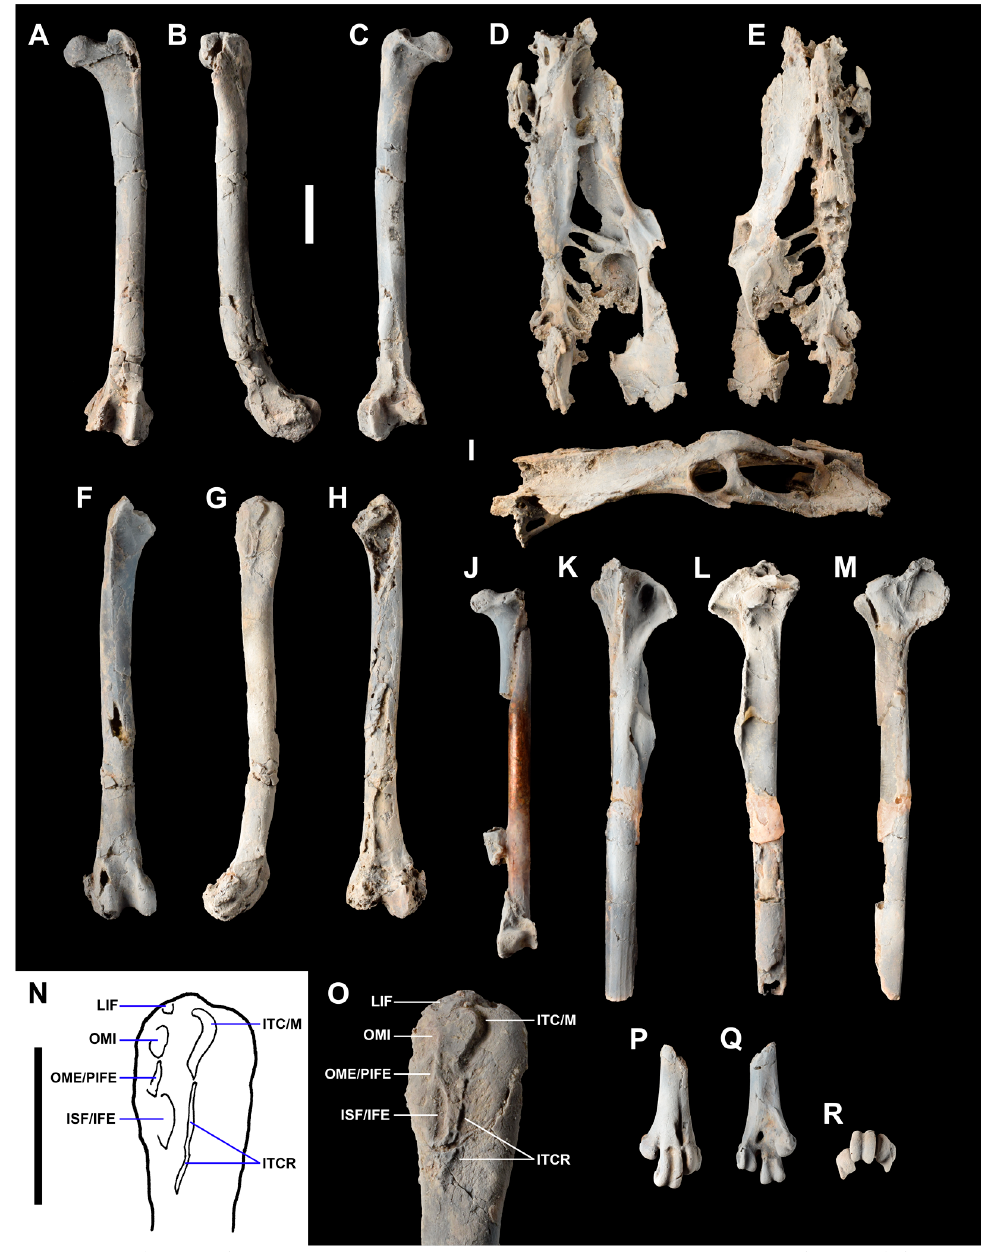
Figure 3. Holotype of Anachronornis anhimops nov. gen. et sp. (USNM 496700): femora, left cranial ( A ), lateral ( B ), caudal ( C ), right cranial ( F ), lateral ( G ), enlarged labeled proximal lateral ( N , O ), caudal ( H ); pelvis, ventral ( D ), dorsal ( E ), left lateral ( I ); proximal left tibiotarsus, cranial ( K ), caudal ( L ), medial ( M ); distal left tarsometatarsus, cranial ( P ), caudal ( Q ), distal ( R ). Femur (USNM 496702; Anseriformes fam. incertae sedis) caudal fragmentary right femur with metal bar glued in place prior to removal from matrix to preserve length and midsection of shaft glued randomly to bar ( J ).